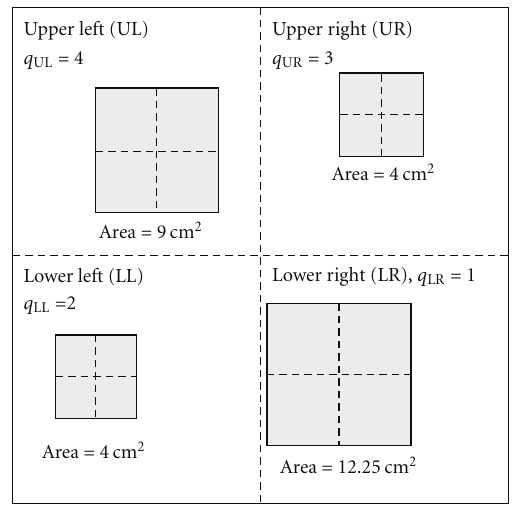
Figure 5: The hypothetical example screen showing inputs required to compute the unity element.